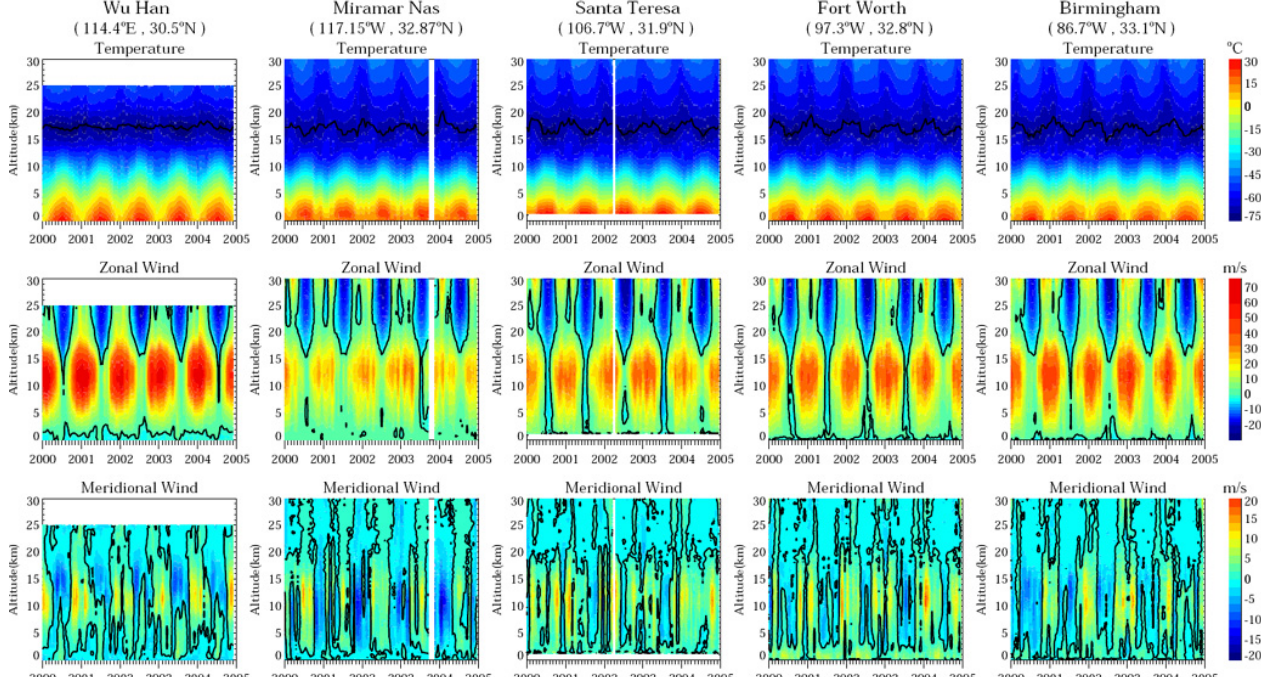
Fig. 2. Time-height cross-sections of the background temperature (top), zonal (middle) and meridional (bottom) winds during 2000–2004. The solid lines denote the coldest point of temperature (top) and wind velocity of 0ms − 1 (middle and